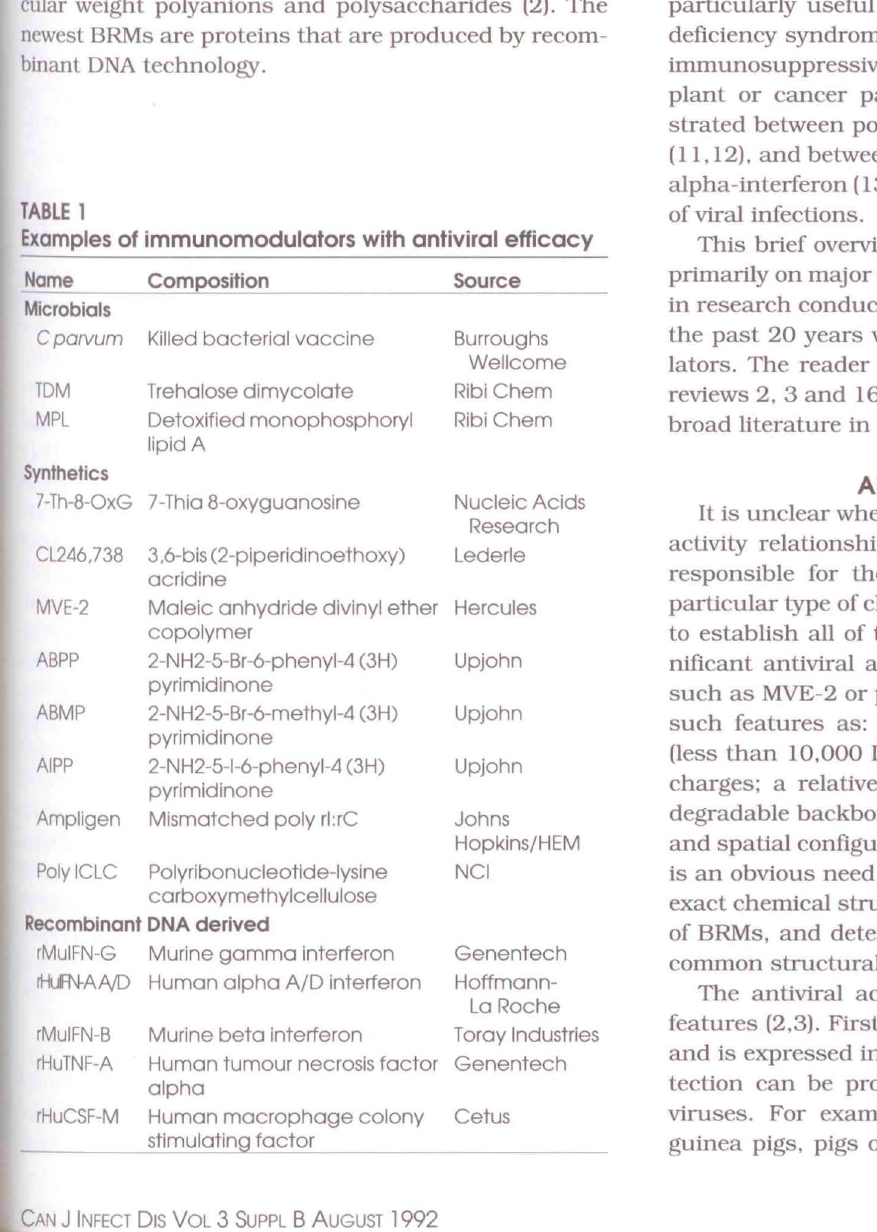
Examples of immunomodulators with antiviral